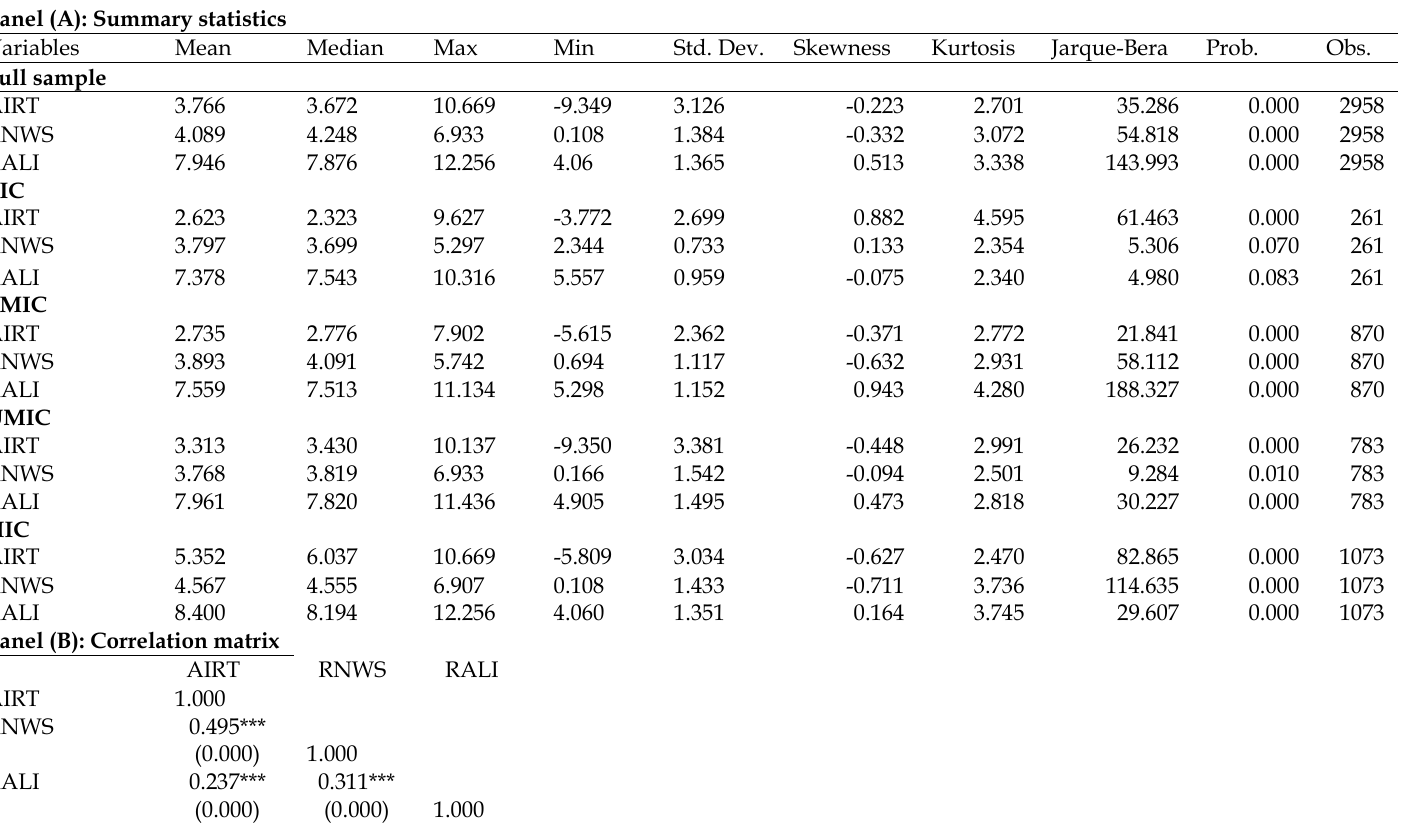
Table 2: Summary statistics and correlation matrix